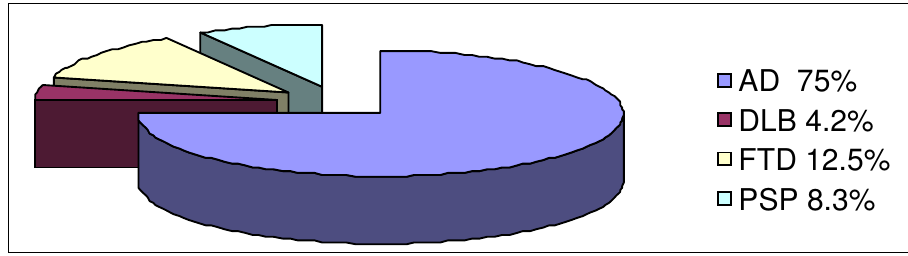
FIGURE 2 . Clinical evolution observed in the MCI patients converting to